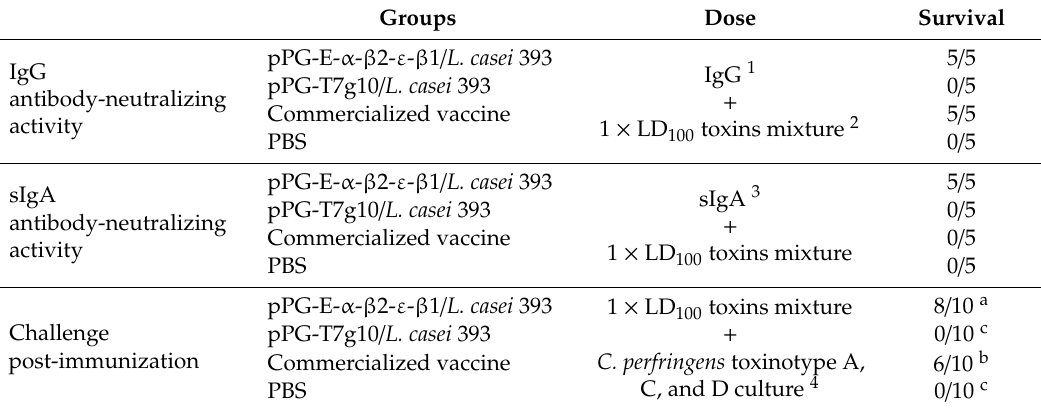
Table 1. Immune protection e ffi cacy of the bait particle vaccine.